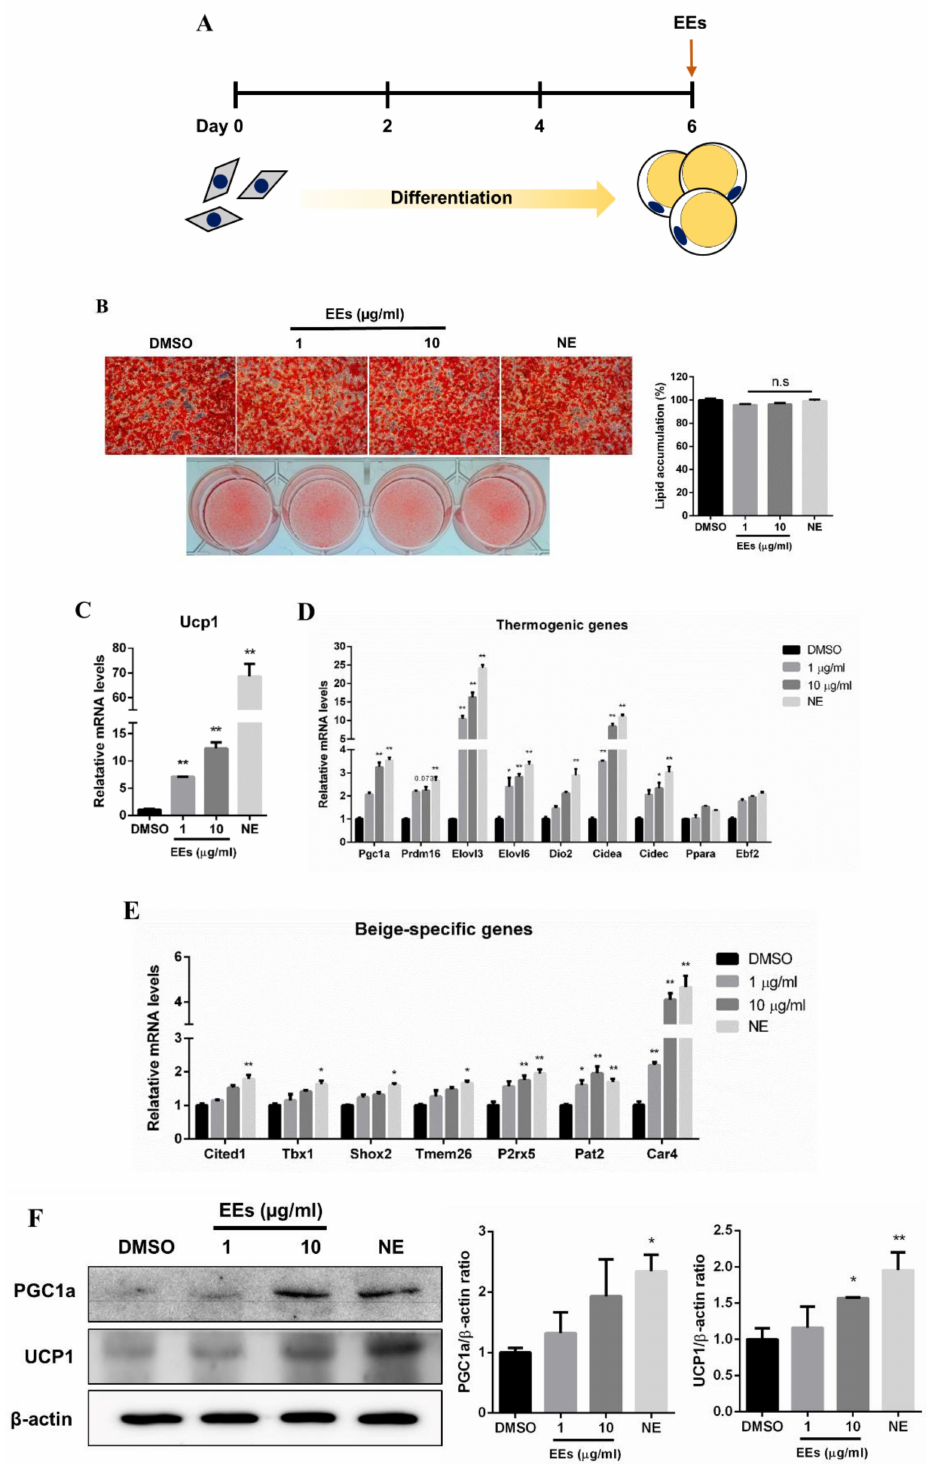
Figure 2. Effects of EEs on the browning process in differentiated mIPA. ( A , B ) Fully differentiated mIPA were treated with EEs for 6 h and stained with ORO dye. ( C – E ) Expression levels of Ucp1 , thermogenic genes, and beige-specific genes in EEs-treated cells were investigated by real-time qPCR and compared with controls (DMSO and NE groups). ( F ) Protein levels of UCP1 and PGC1a were analyzed by Western blotting. Results are shown as mean ± SEM ( n = 3). *, p < 0.05; **, p < 0.01 compared to the untreated control